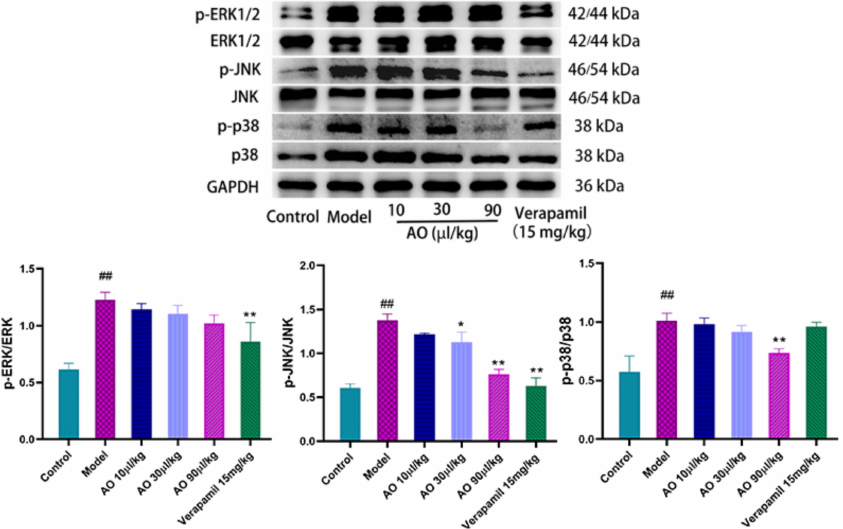
Figure 6. Effect of AO on the expression of MAPK pathway-related proteins in GM-induced AKI kidney of rats. ## p < 0.01 vs. control group. * p < 0.05, ** p < 0.01 vs. Model